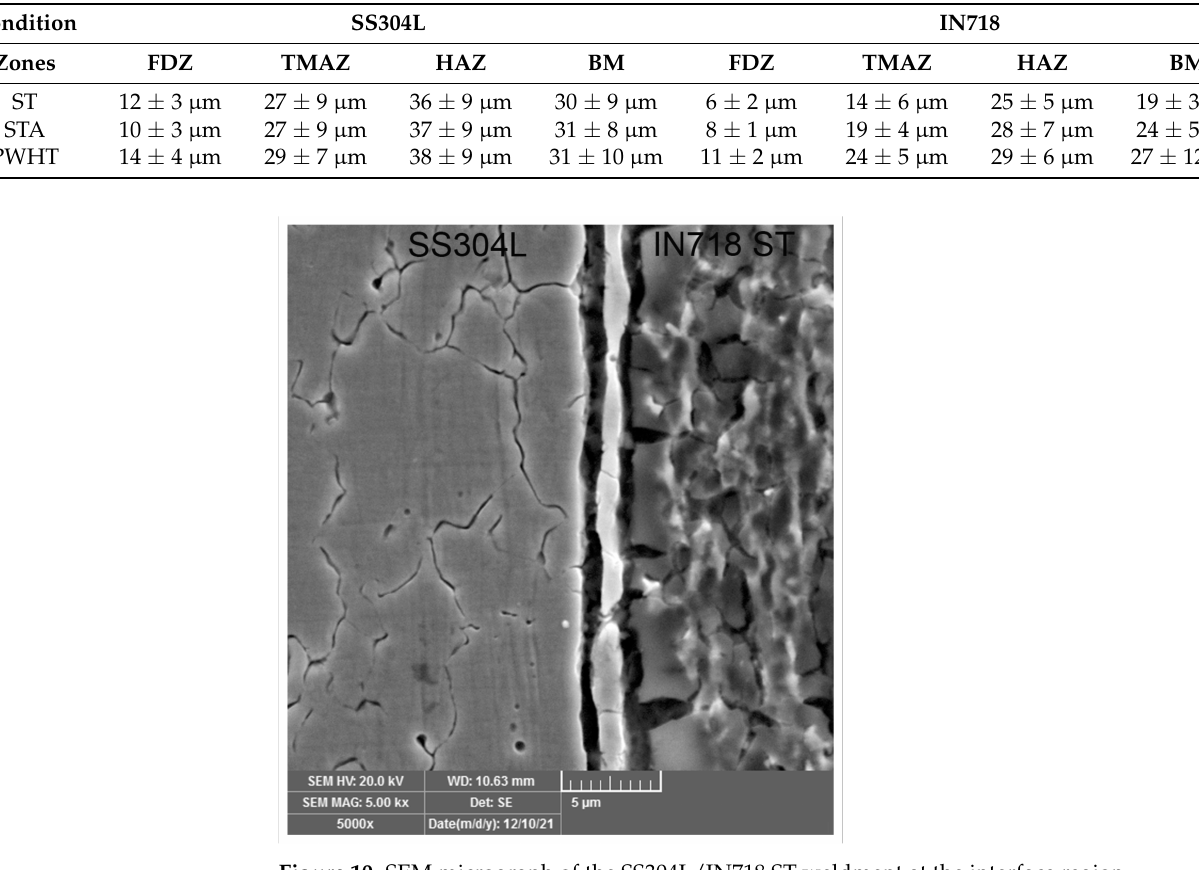
Figure 10. SEM micrograph of the SS304L/IN718 ST weldment at the interface